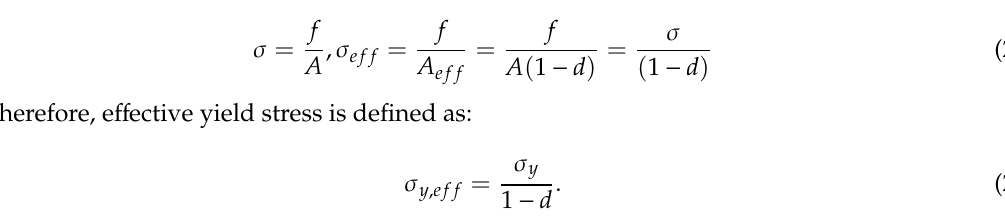
Figure 5. ( a ) Plastic strain at the onset of damage as function of stress triaxiality; ( b ) Damage parameter, d vs. true plastic